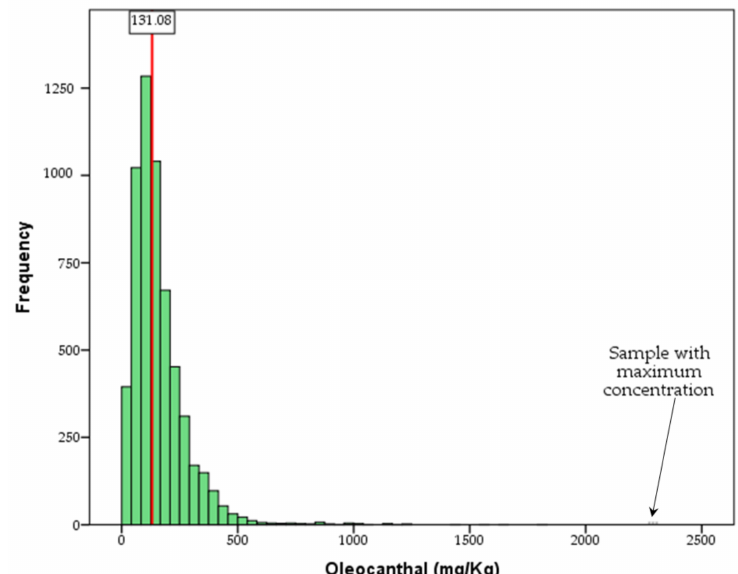
Figure 2. The oleocanthal distribution of the analyzed olive oil samples ( n = 5764). The red line represents the